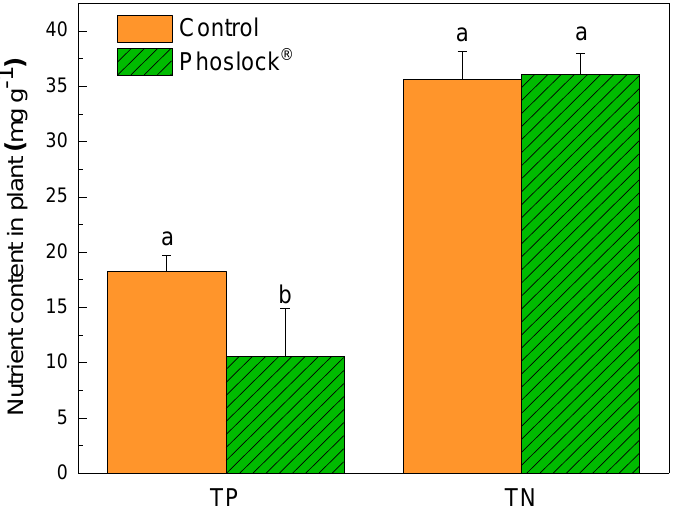
Figure 4. The contents of phosphorus and nitrogen in Myriolhyllum spicatum in the control (without Phoslock ® addition) and Phoslock ® addition treatments, respectively. Different letters indicate a significant difference between the two treatments at p < 0.05. Error bars represent the standard deviations